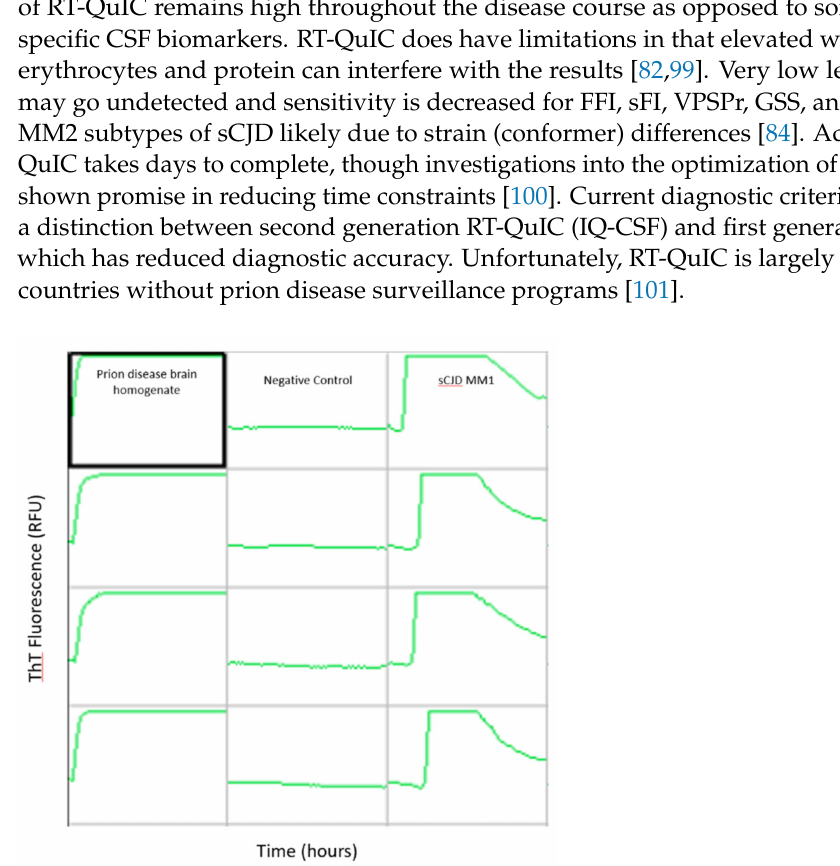
Figure 2. Real-time quaking-induced conversion reactions seeded with prion disease brain ho- mogenate, and cerebrospinal fluid from a negative control and a positive result from a patient with the MM1 subtype of sporadic Creutzfeldt–Jakob disease (sCJD MM1). Each sample is run in